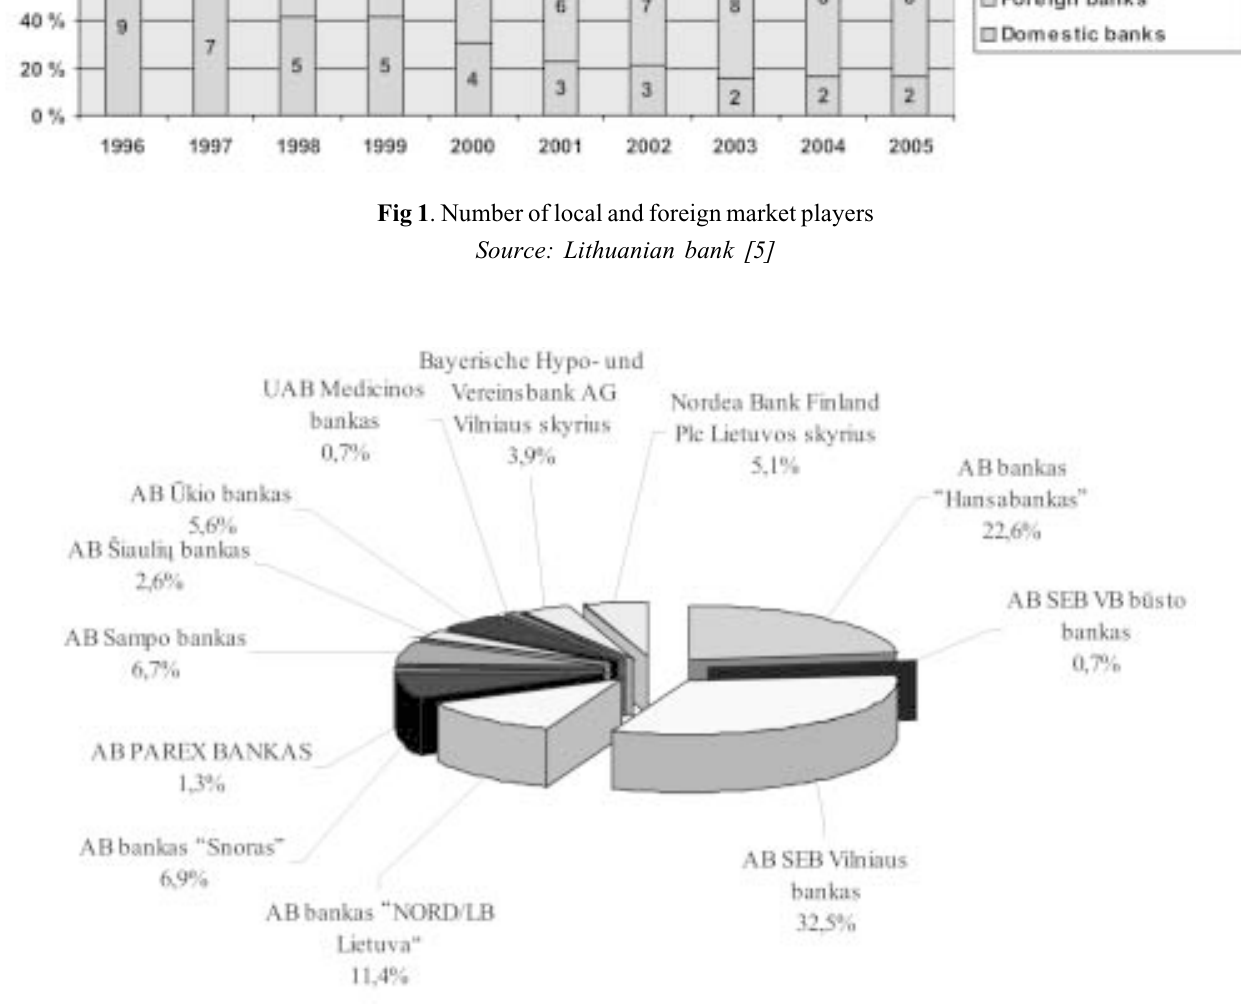
Fig 2 . Current market players in Lithuanian banking sector